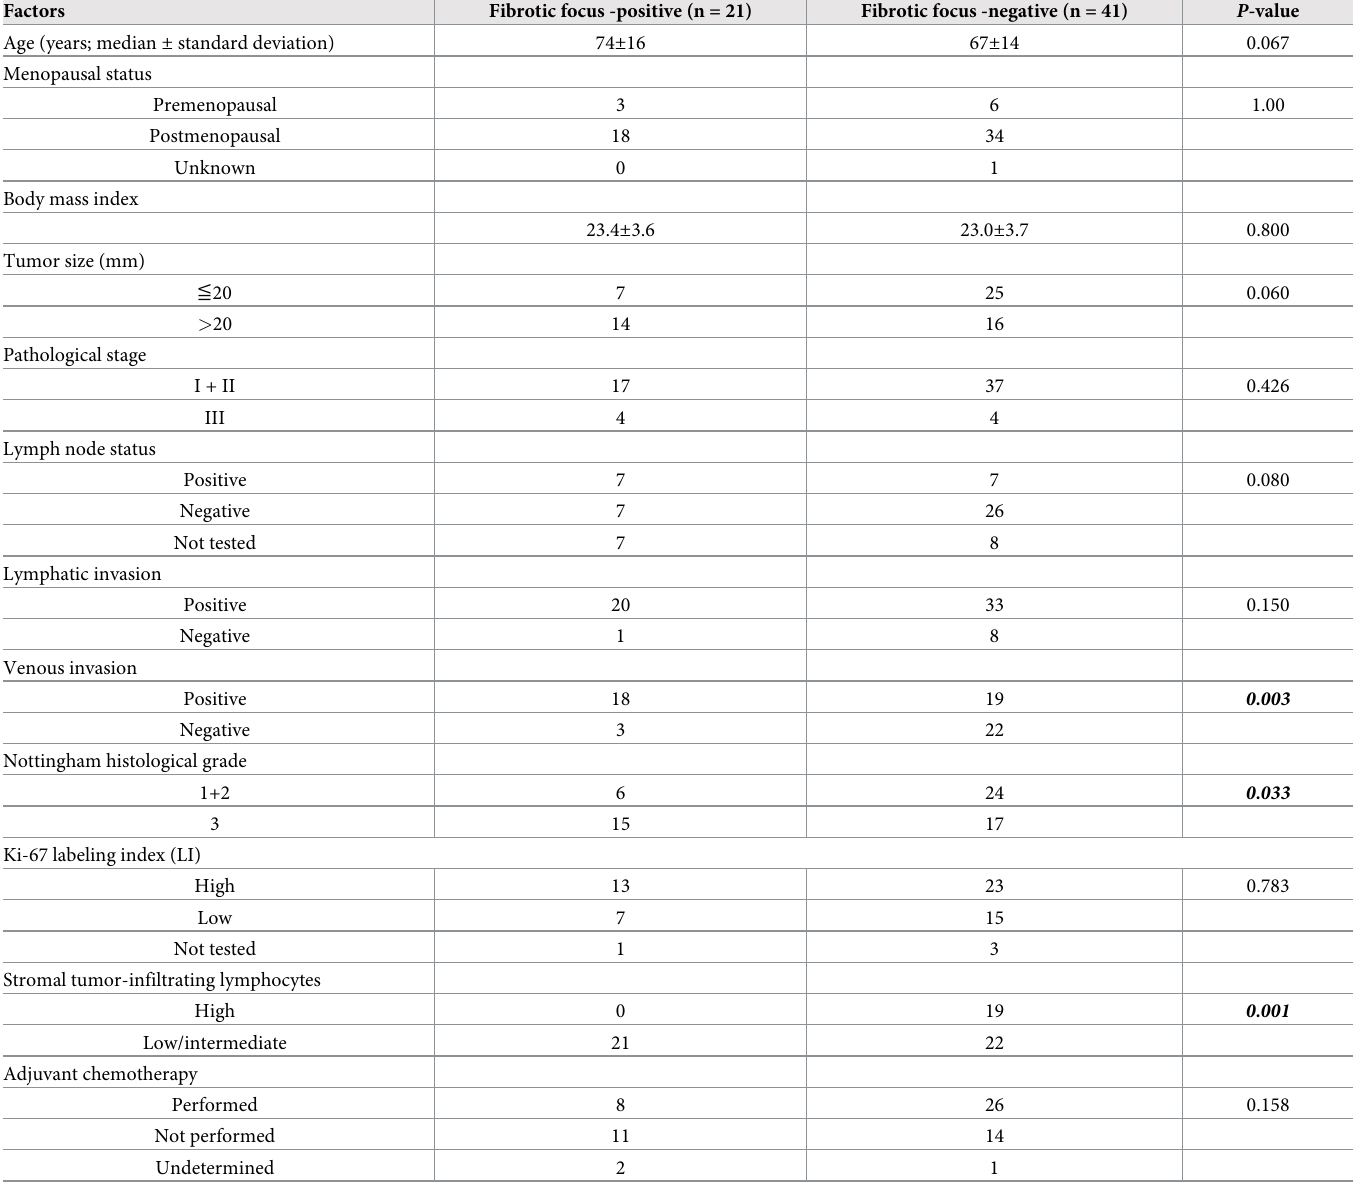
RFS curves of myxoid change- and FF-positive vs. myxoid change- and/or FF-negative patients. Presence of both myxoid change and FF was significantly correlated with poor OS ( p = 0 . 002 ) and RFS ( p = 0 . 001 ) in patients with TNBC. Table 4 summarizes the association of both myxoid change- and FF-positive patients vs. myxoid change- and/or FF-negative patients with clinicopathological factors. Myxoid change- and FF-positive patients were significantly associated with the presence of venous invasion and a high Nottingham histological grade ( p = 0 . 002 and 0 . 044 , respectively) (Table 4). How- ever, pathological stage, lymph node status, lymphatic invasion, and Ki-67 LI were not signifi- cantly different between both groups. Presence of myxoid change and FF were significantly associated with low/intermediate TILs in the stroma ( p = 0 . 013 ). Table 3. Association of fibrotic focus with clinicopathological factors.